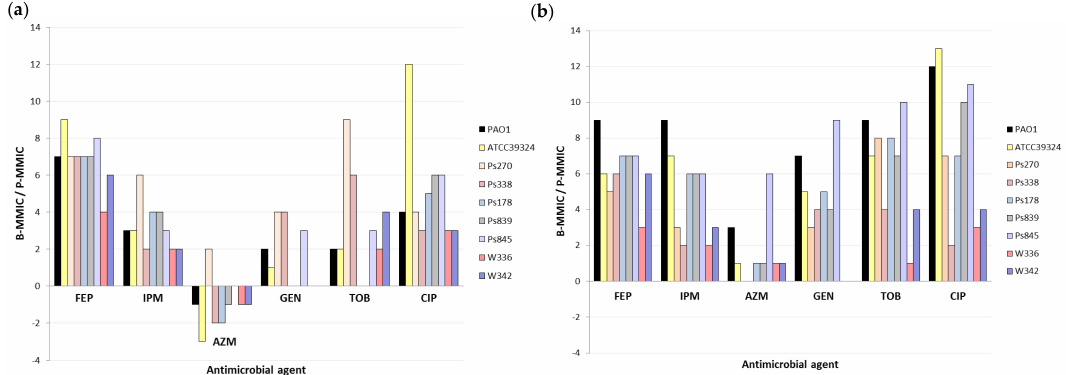
Figure 1. Fold change of serial twofold dilutions of Biofilm Minimum Metabolic Inhibitory Concentrations (B-MMICs) and Planktonic Minimum Metabolic Inhibitory Concentrations (P-MMICs) (B-MMIC/P-MMIC) in ( a ) aerobiosis and ( b ) microaerobiosis. FEP, cefepime; IPM, imipenem; AZM, azithromycin; GEN, gentamicin; TOB, tobramycin; CIP, ciprofloxacin.